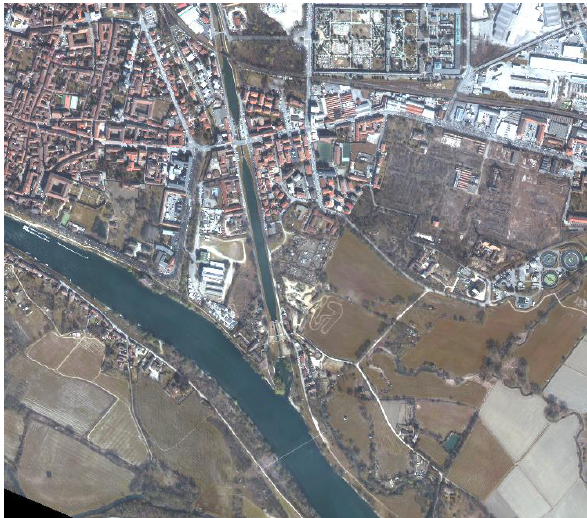
Figure 3. Area of the city of Pavia that has been studied.